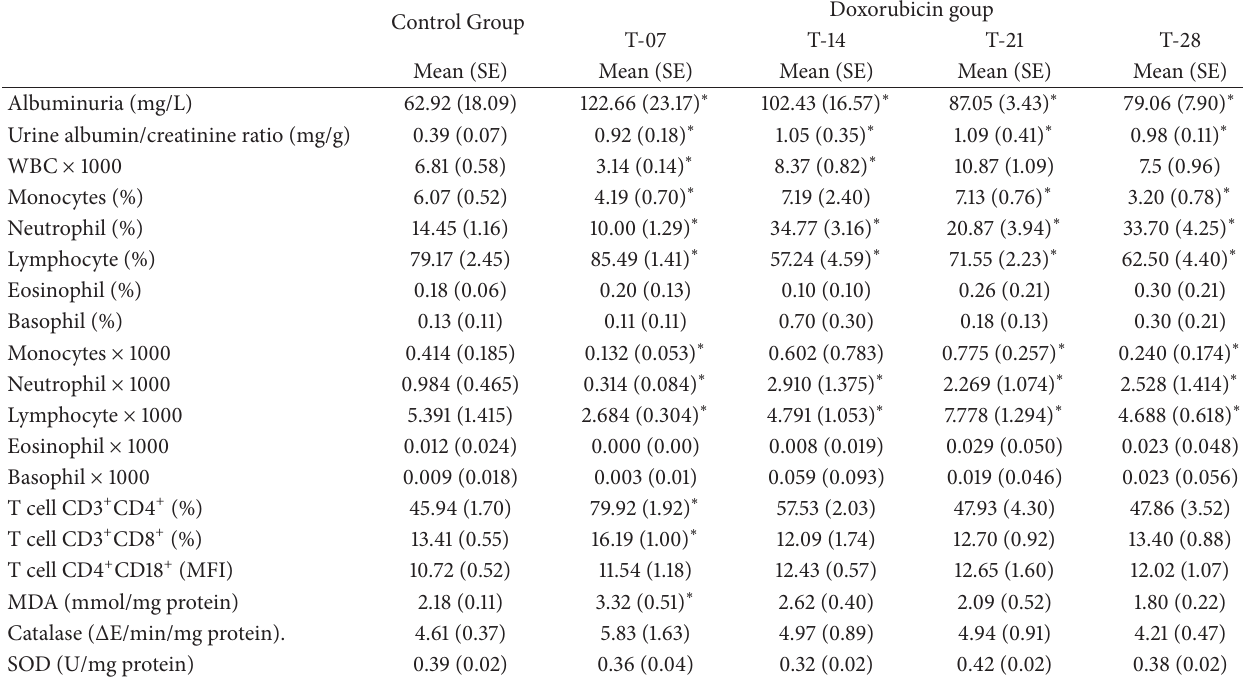
Table 1: Urinary protein excretion, blood cells, and markers of cell surface and of redox status in the kidney of rats with doxorubicin-induced nephropathy and